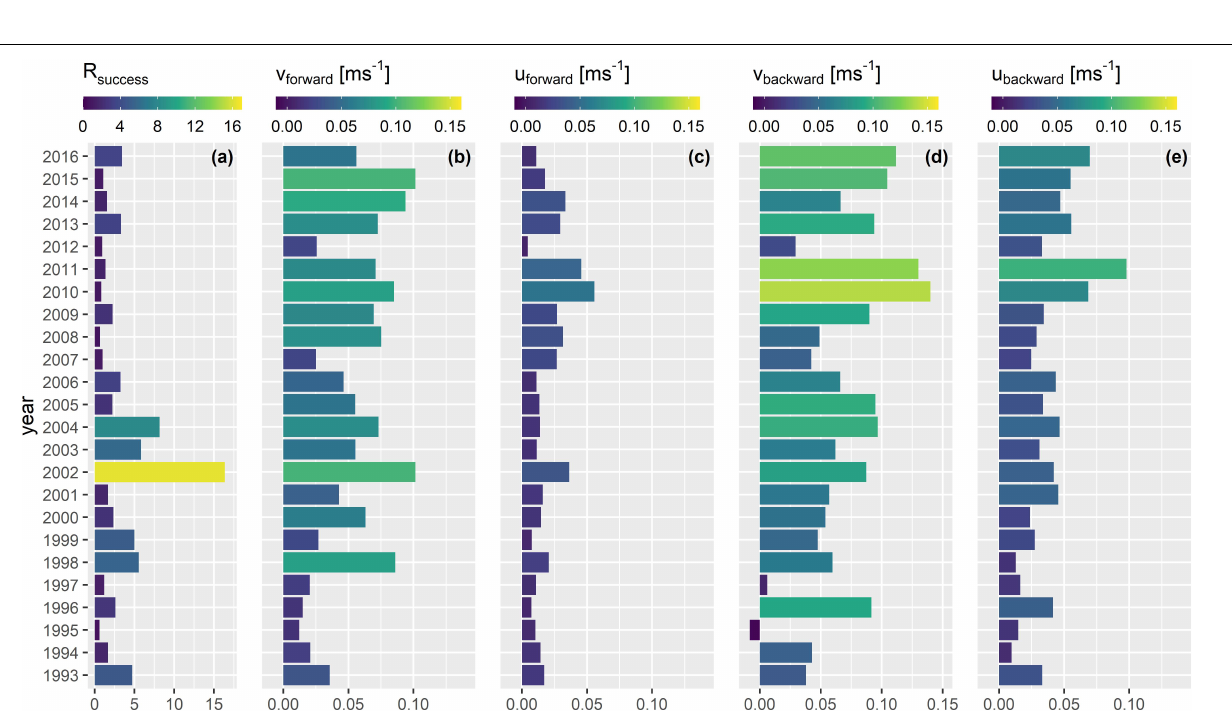
Frontiers in Marine Science |